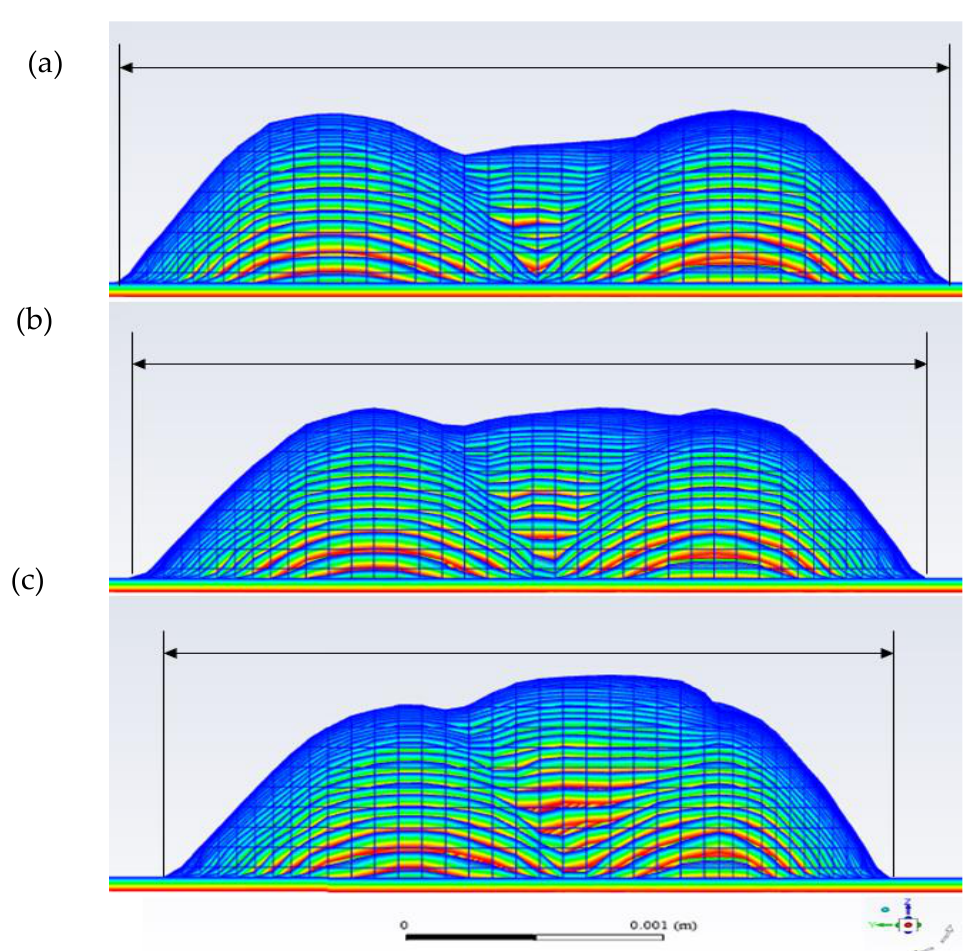
Figure 12. Shapes of deposited layers with varying overlapping rates. ( a ) Overlapping rate of 20%; ( b ) Overlapping rate of 30%; ( c ) Overlapping rate of 40%.